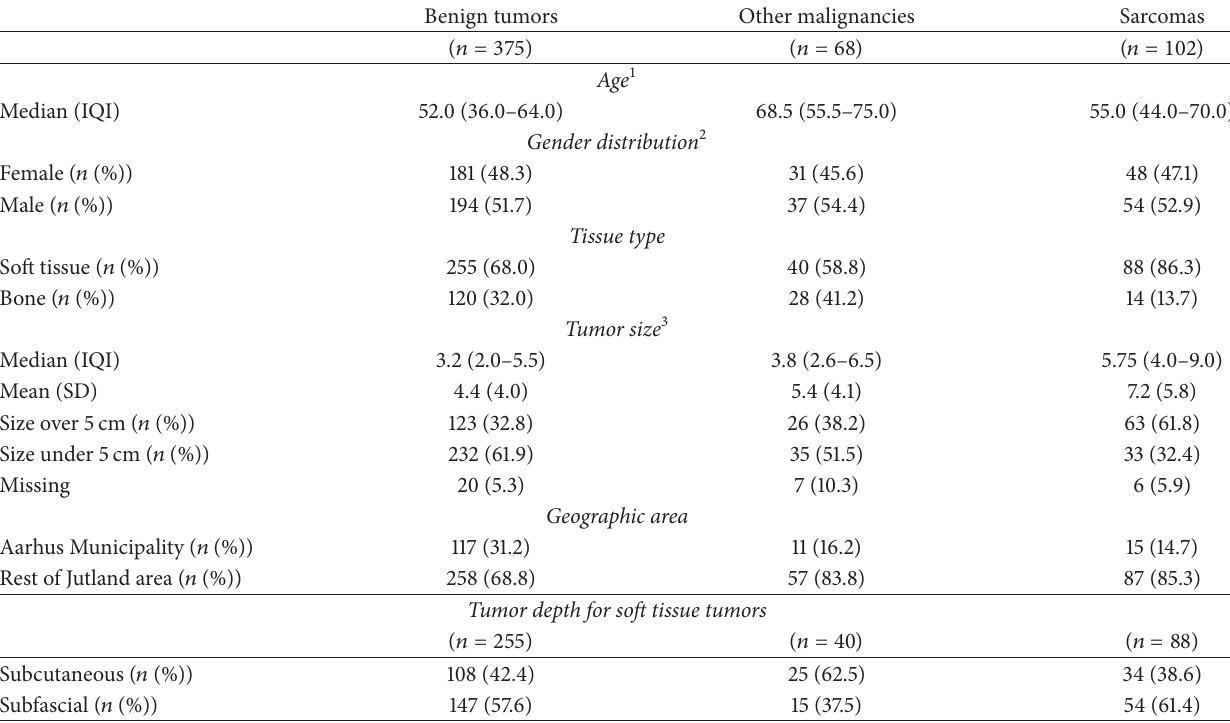
Table 1: Patient and tumor characteristics of 545 patients referred to the Cancer Patient Pathway for sarcomas. Benign